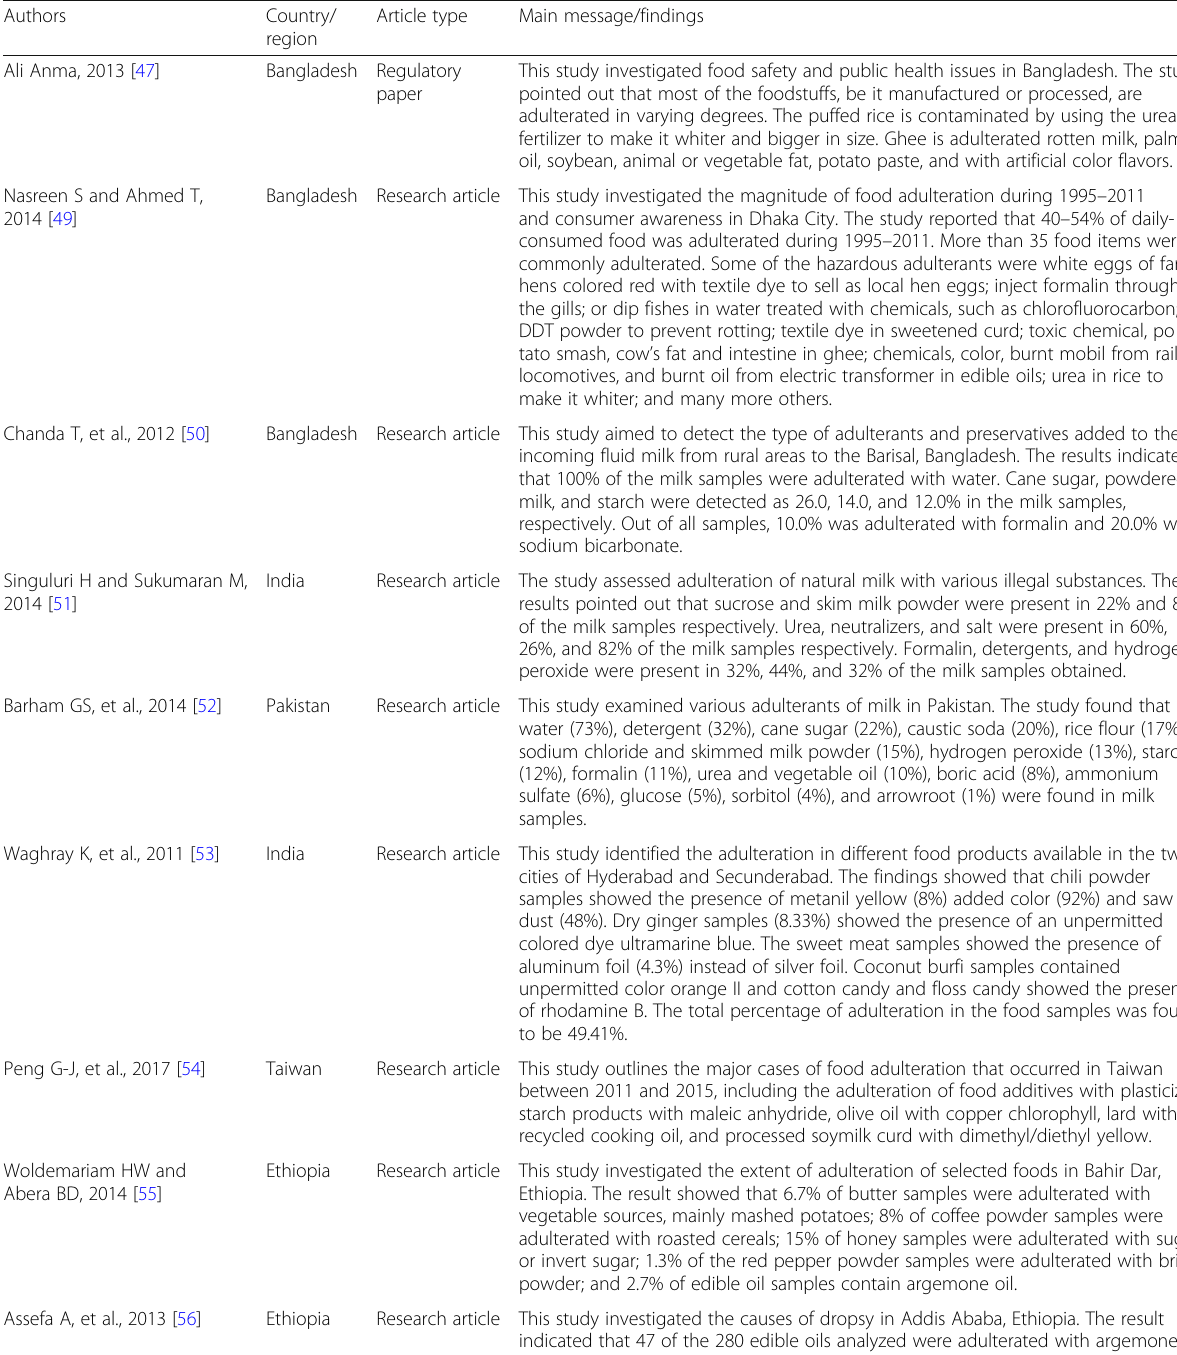
Table 5 Summary of full-text articles which reported food adulteration as a public risk in food